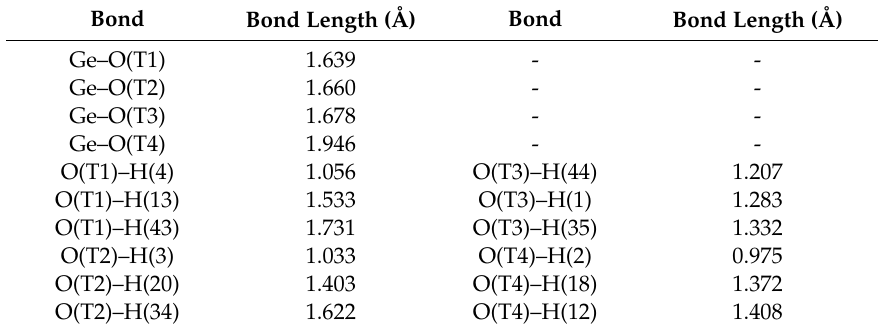
Table 4. Calculated bond lengths (Å) of the Ge-tetrahedra in the tunnel site after DFT-D calculation for the proposed